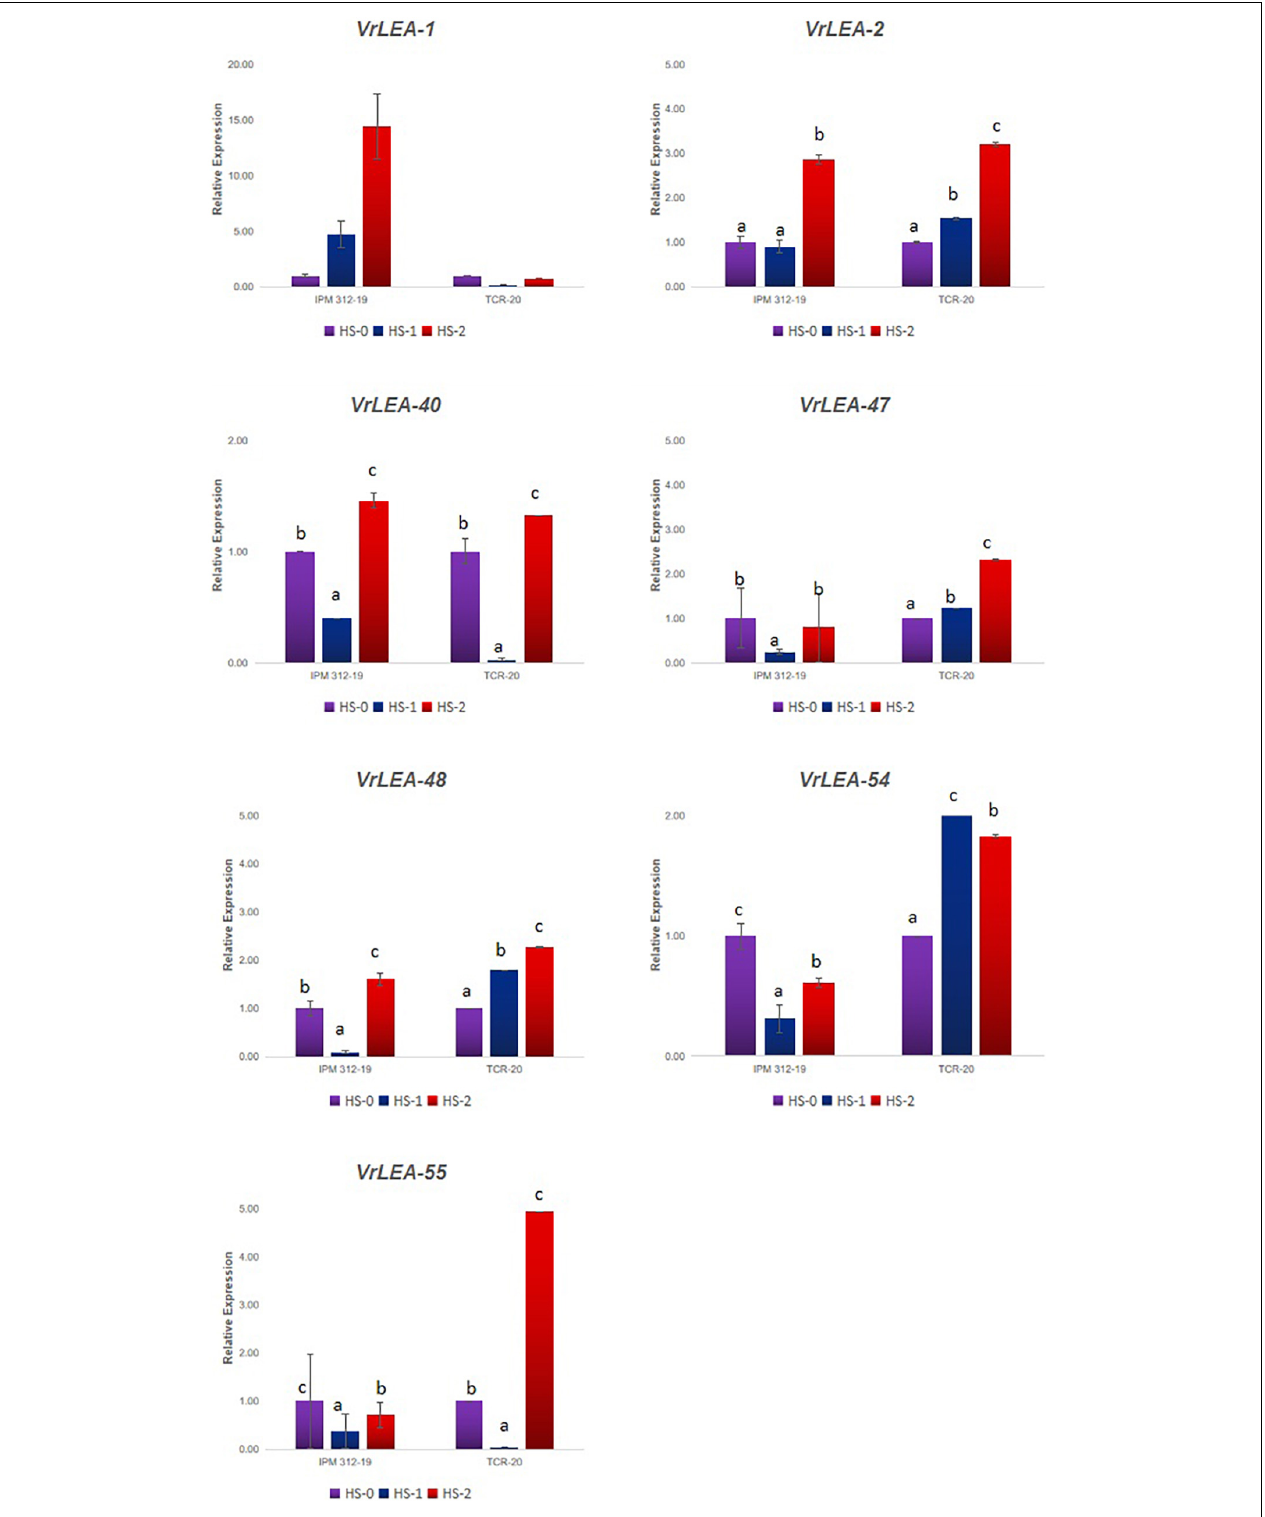
FIGURE 7 | qRT-PCR analysis of selected VrLEA candidate genes on HS-mungbean (IPM 312-19) and HR- V. glabrescens (IC251372) under heat shock stress through detached leaf method. The statistical test was performed separately in both genotypes. The same letters show non-significant differences, whereas different letters show significant